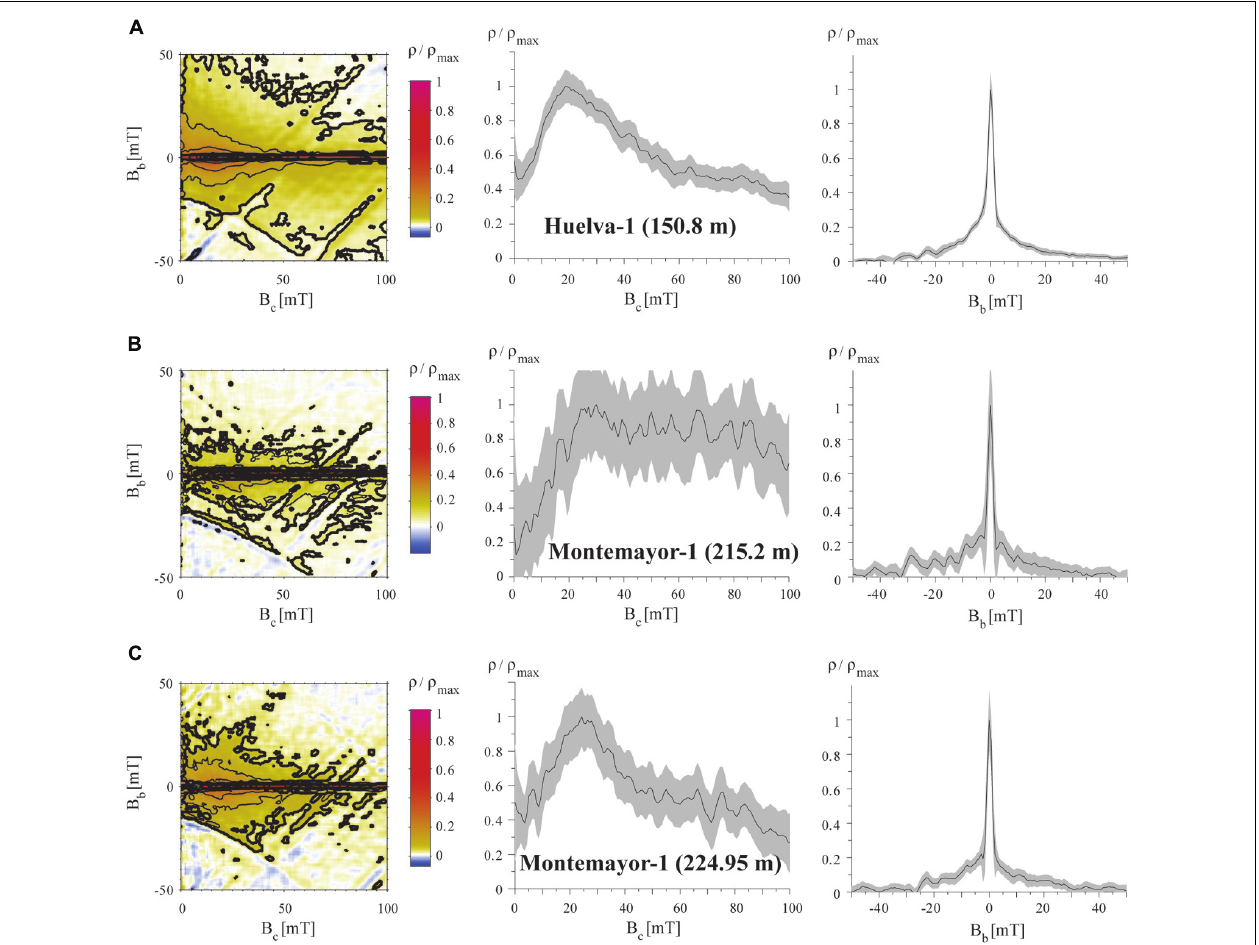
FIGURE 8 | Representative FORC diagrams for samples from the Gibraleón Formation in the Huelva-1 (A) and Montemayor-1 (B,C) boreholes, plotted with horizontal and vertical profiles through the FORC distributions. The stratigraphic position for each sample is shown in parentheses. All samples have a central ridge signature typical of intact magnetosome chains (Egli etal., 2010),